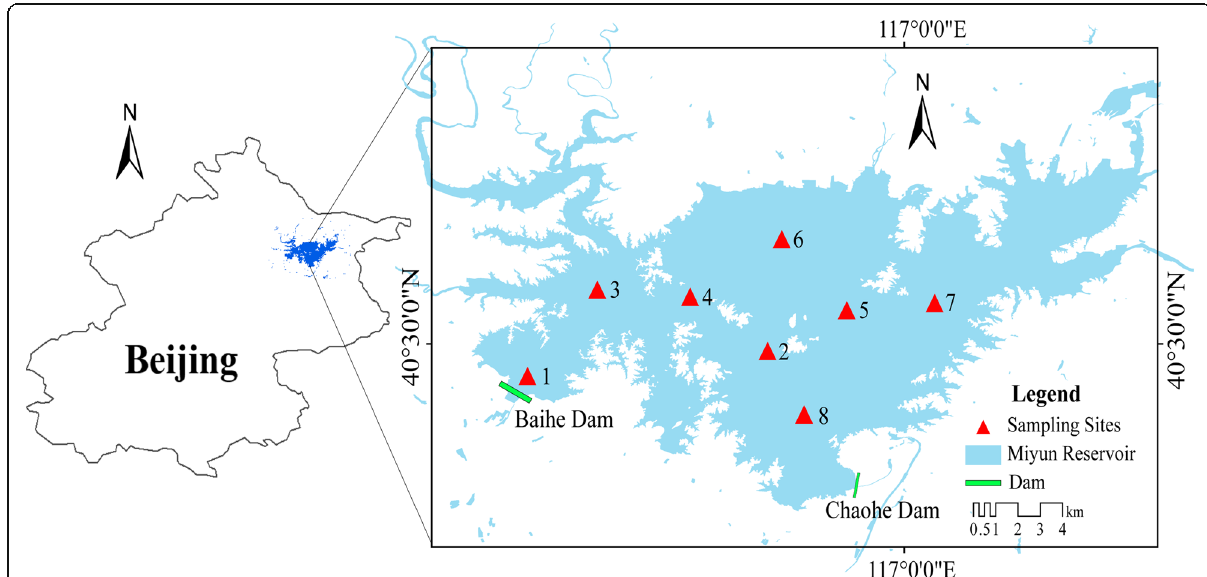
Fig. 1 Schematic representation of sampling sites in Miyun Reservoir